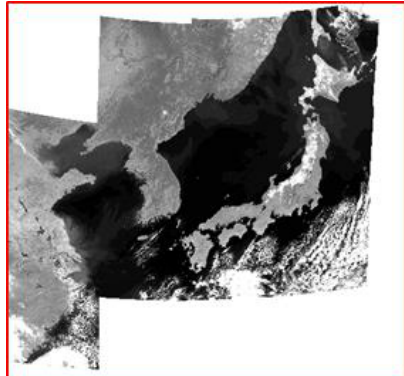
Figure 5. Precise sensor modelling of images including